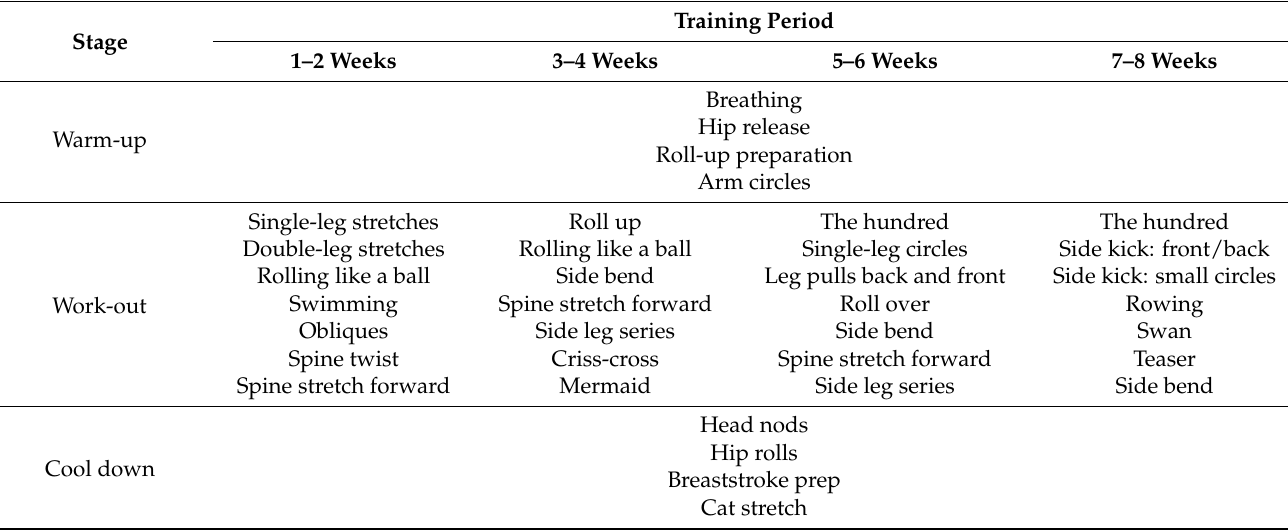
Table 1. Pilates training program for adolescent